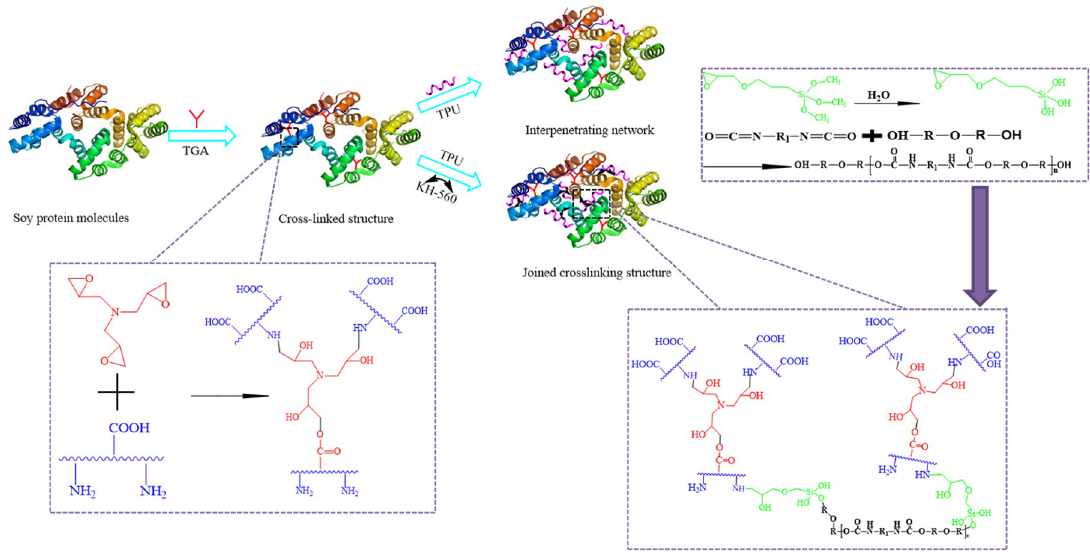
Figure 4. The reaction scheme of the adhesive.